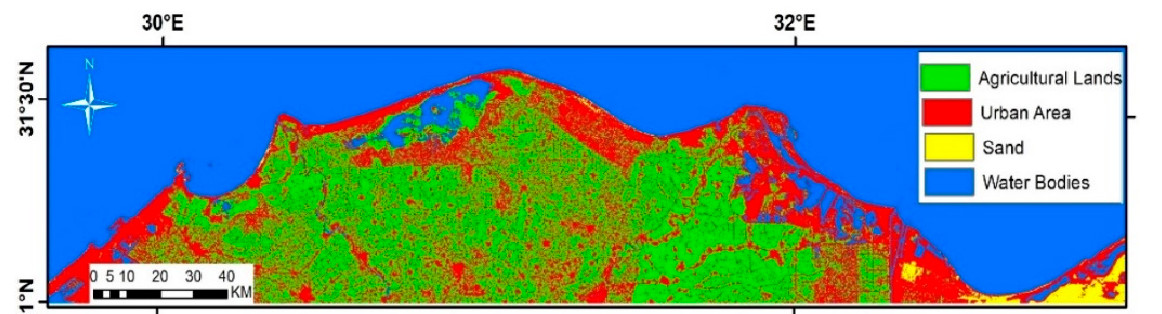
Figure 2. Land use of the study area.